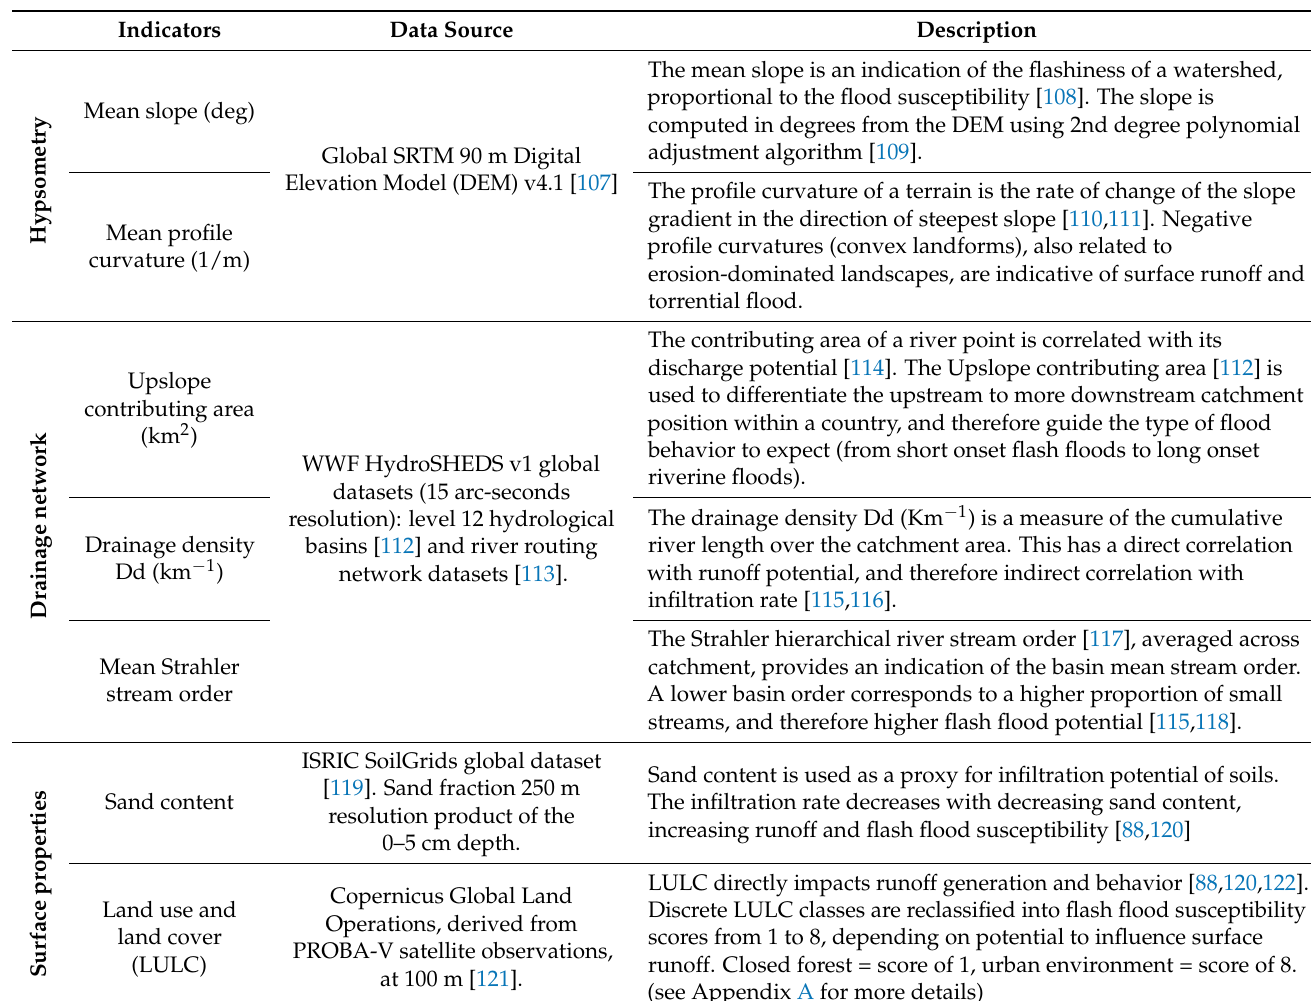
Table 2. Flash flood susceptibility indicators calculated at catchment scale, and related information for hypsometry, drainage network and surface